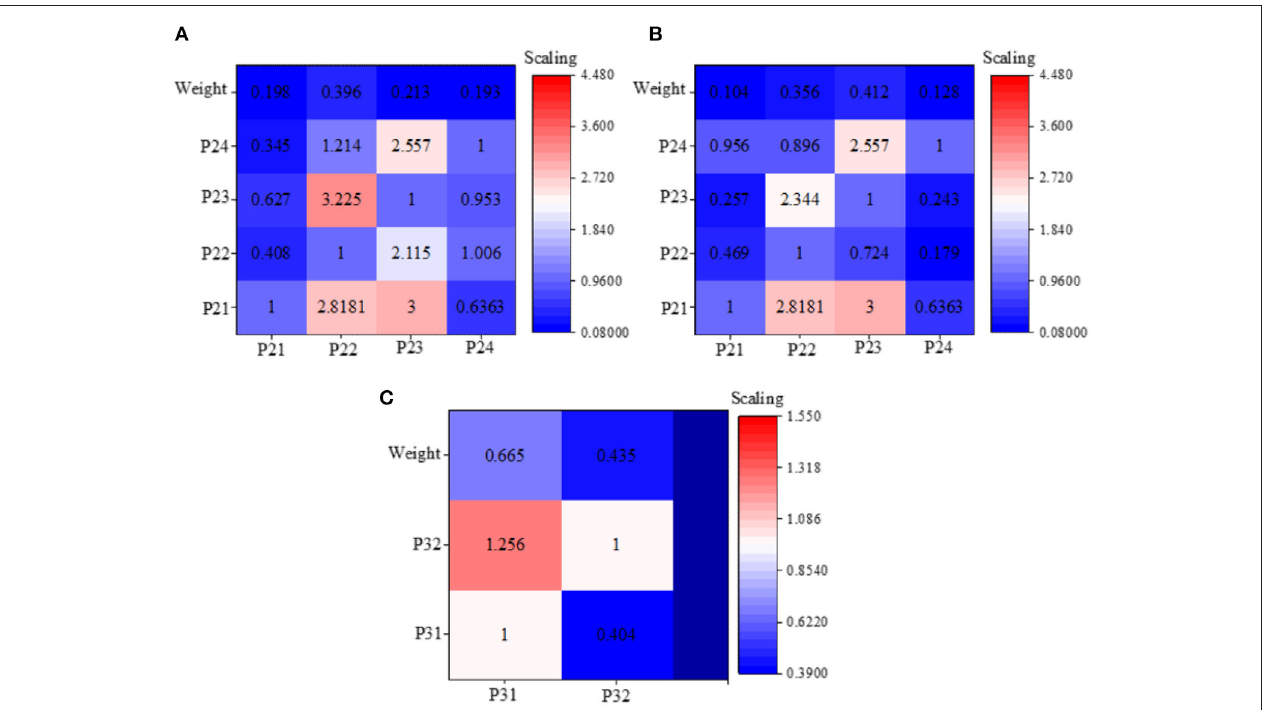
FIGURE 7 | Weighted results of various indexes of the smart tourism platform based on tourist psychology [ (A) is the technical level index weighting result; (B) is the external environment index weighting result; (C) is the basic condition index weighting result].